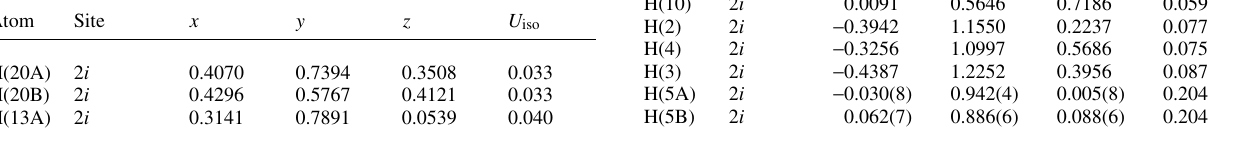
Table 2. Atomic coordinates and displacement parameters (in Å 2 ) .